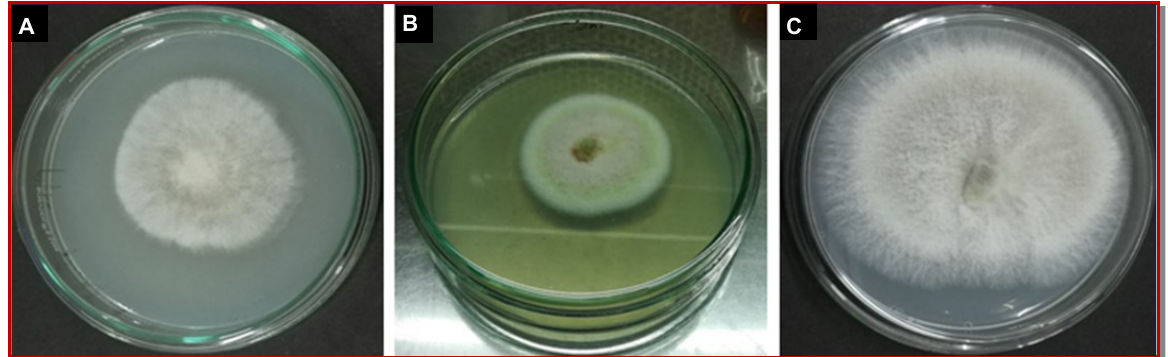
Figure 1: Endophytic fungal colony characteristics in PDA plates PTR1 (A), PTR2 (B), PTR3 (C)